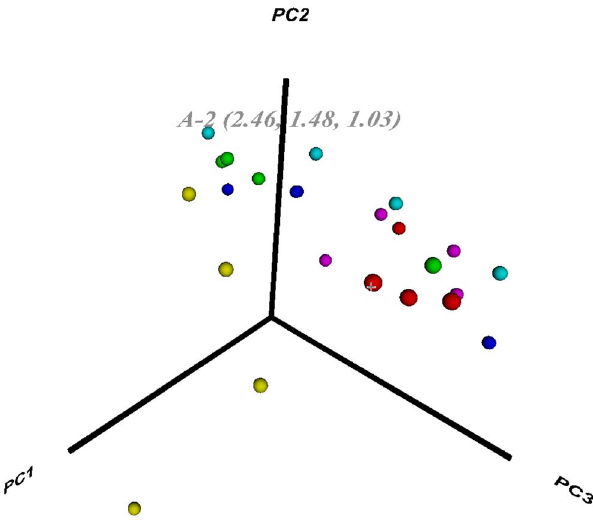
Figure 6. Example of a PCA plot generated in VRML format by PIIKA 2. In this experiment, samples were taken from subjects labeled A, B, C, D, E, and F. Samples corresponding to subject A are in red, subject B are in yellow, and so on. The label near the top of the figure is the result of hovering the mouse over the leftmost red circle, and shows that the first, second, and third principal components for this sample had the values 2.46, 1.48, and 1.03, respectively. This image is an example of the visualization given using the VRML viewer Instant Player ( http://www.instantreality.org ). doi:10.1371/journal.pone.0080837.g006 resulting heatmap is shown in Figure 1, with the sample (column) dendrogram showing that samples from the same subject tended to cluster together quite well, although not perfectly. The question is, do samples from the same subject cluster together better than would be expected by chance?